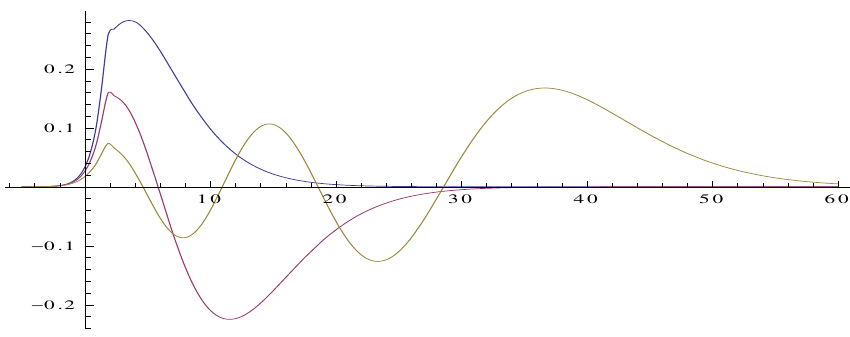
Figure 25 . Three leading wavefunctions (No 1,2,5) for the scale k = 1 GeV, as a function of ln q 2 .